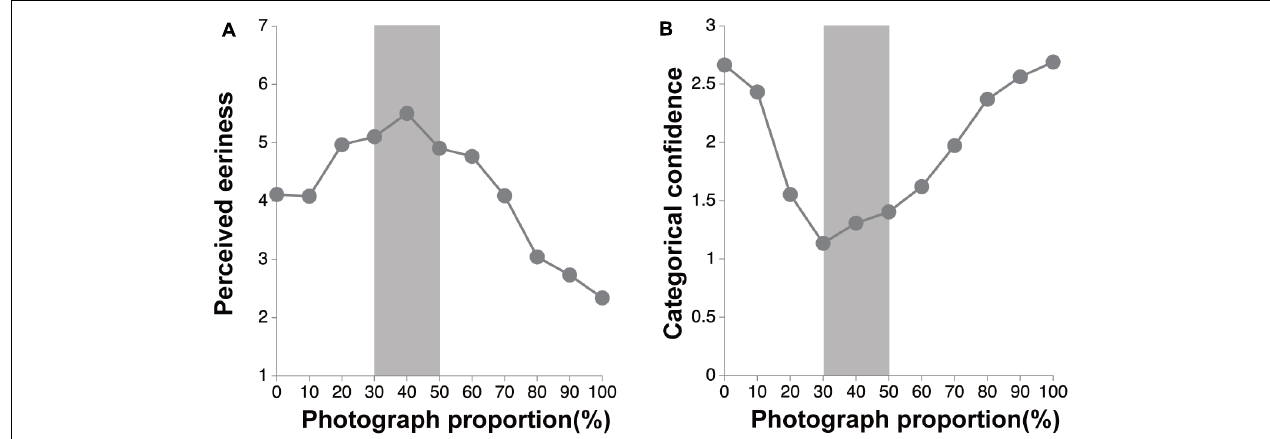
FIGURE 3 | The results of the eeriness evaluation and the categorization tasks. Error bars denote the standard errors of the mean. The gray zone indicates a hard-to-categorize interval (30–50%). (A) The perceived eeriness for each photograph proportion. (B) The categorical confidence for each photograph proportion.